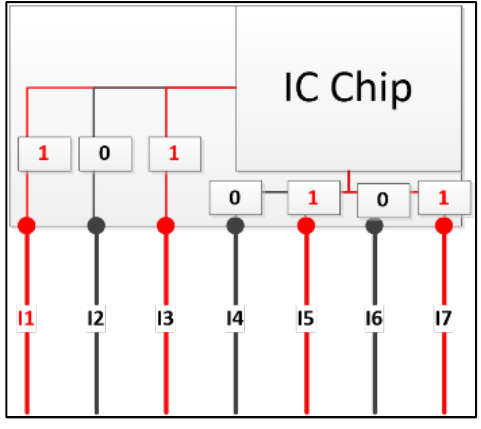
Figure 4. Flow of data signals when they come to ingress ports of MUXER.